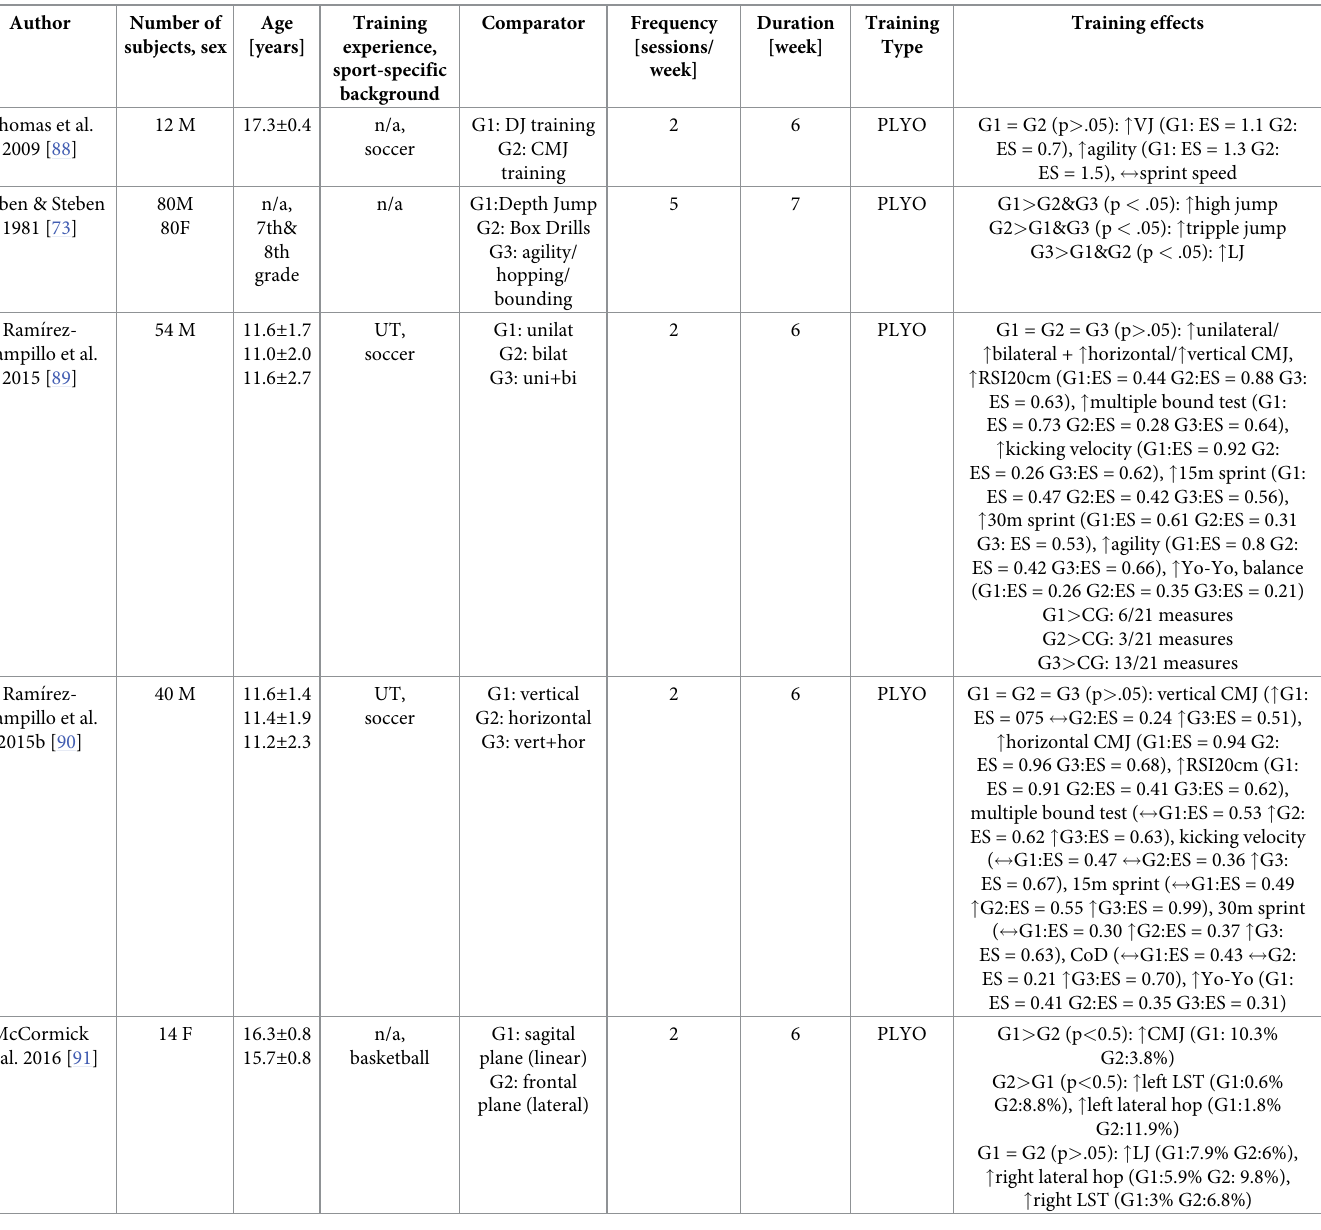
Table 11. Influence of the moderating variable ‘training specificity’ on plyometric training induced improvements in components of physical